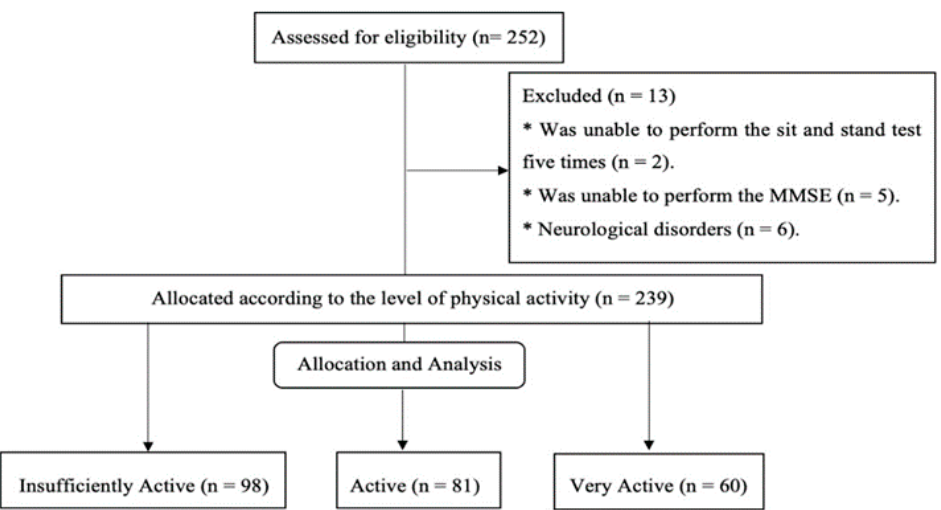
Figure 1. The flow diagram of the groups represents the allocation of Insufficiently Active, Active, and Very Active groups according to their level of physical activity (PA).